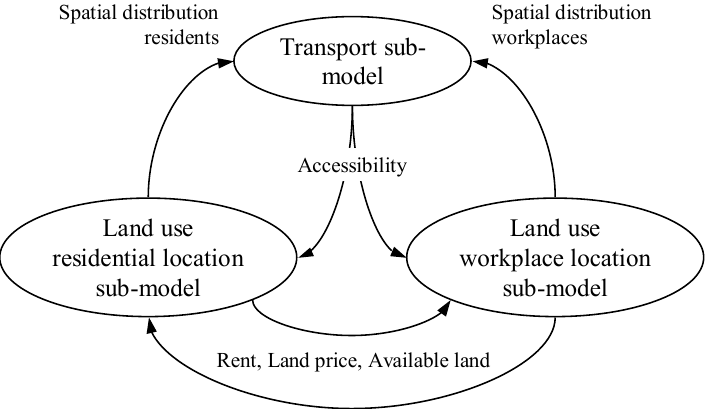
Figure 5: Link between the transport and the land use sub-model of the